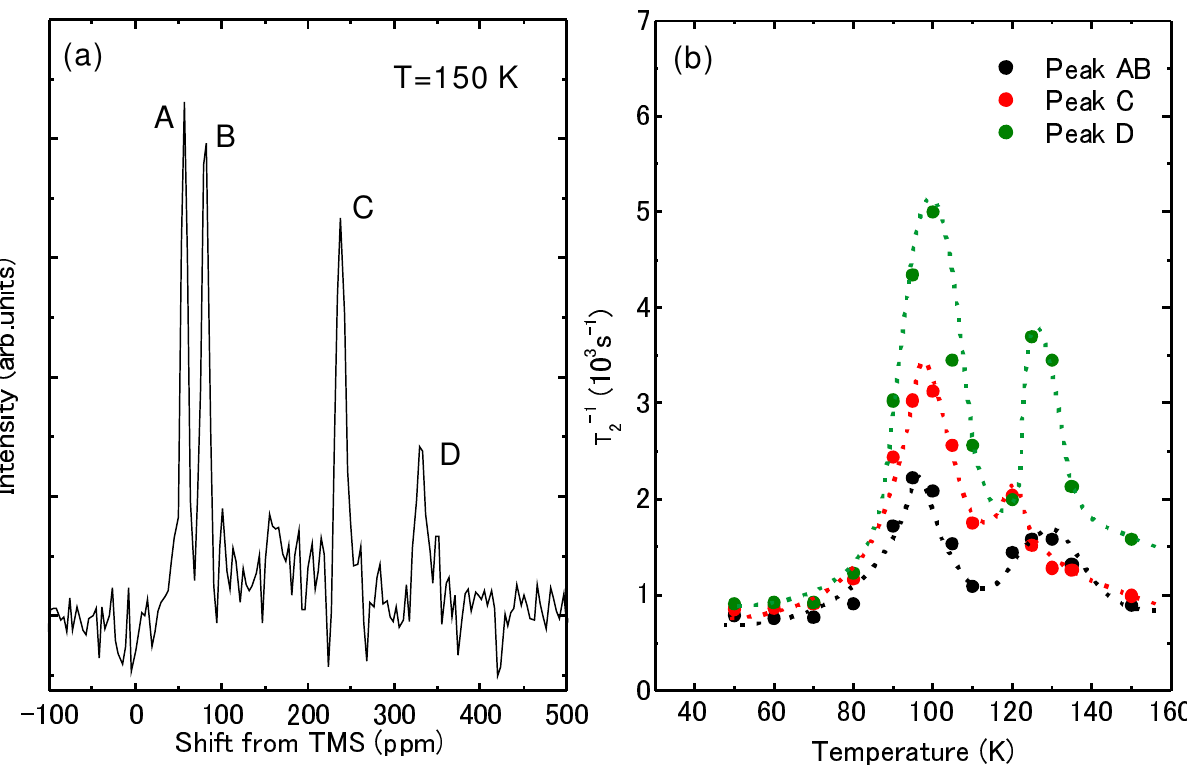
Cu(NCS) ; ( b ) Temperature 2 2